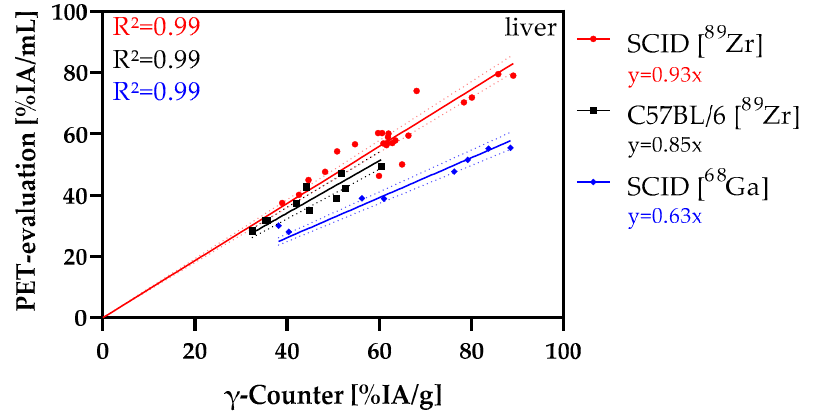
Figure 8. Comparison of PET-derived (ordinate) and gamma counter-derived (abscissa) liver data regarding the respective mouse model and radionuclide. The correlations between the two evaluation methods were additionally demonstrated by presenting the functional equations and the corresponding variances (R²).